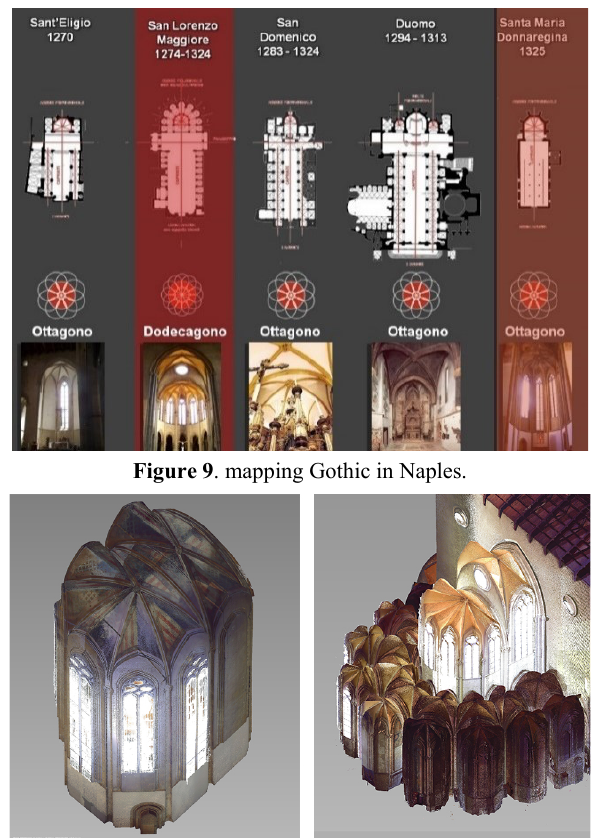
Figure 10 . Data acquisition – S. Lorenzo and Donnaregina point cloud from laser scanner The output of the CLUSTER 1 are three different configurations for plan ribs distribution: 1.diagonal ribs, 2.centre trapezoid ribs, 3. midpoints